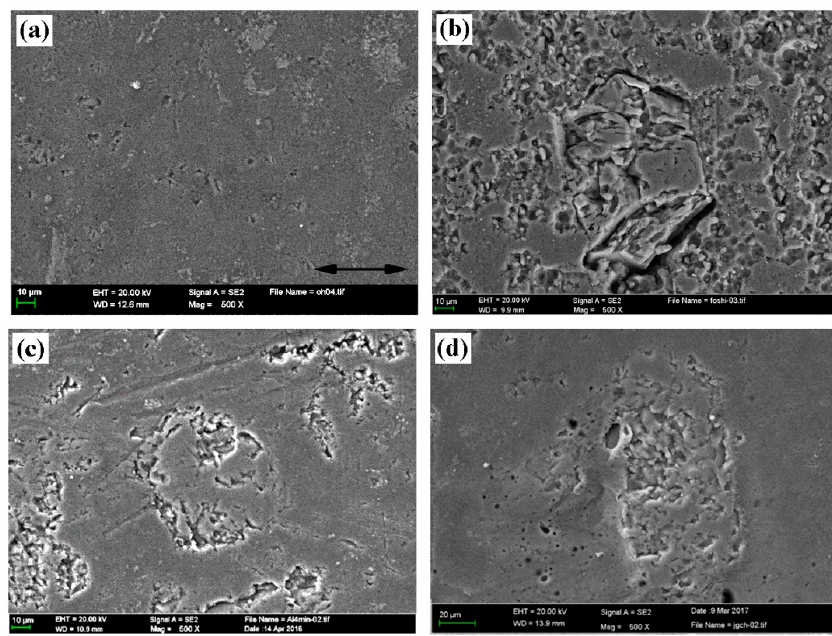
Figure 15. The worn surface morphologies of the Al–Si alloy cylinder liner: ( a ) Untreated; ( b ) chemical etching; ( c ) mechanical honing; ( d ) laser finishing.